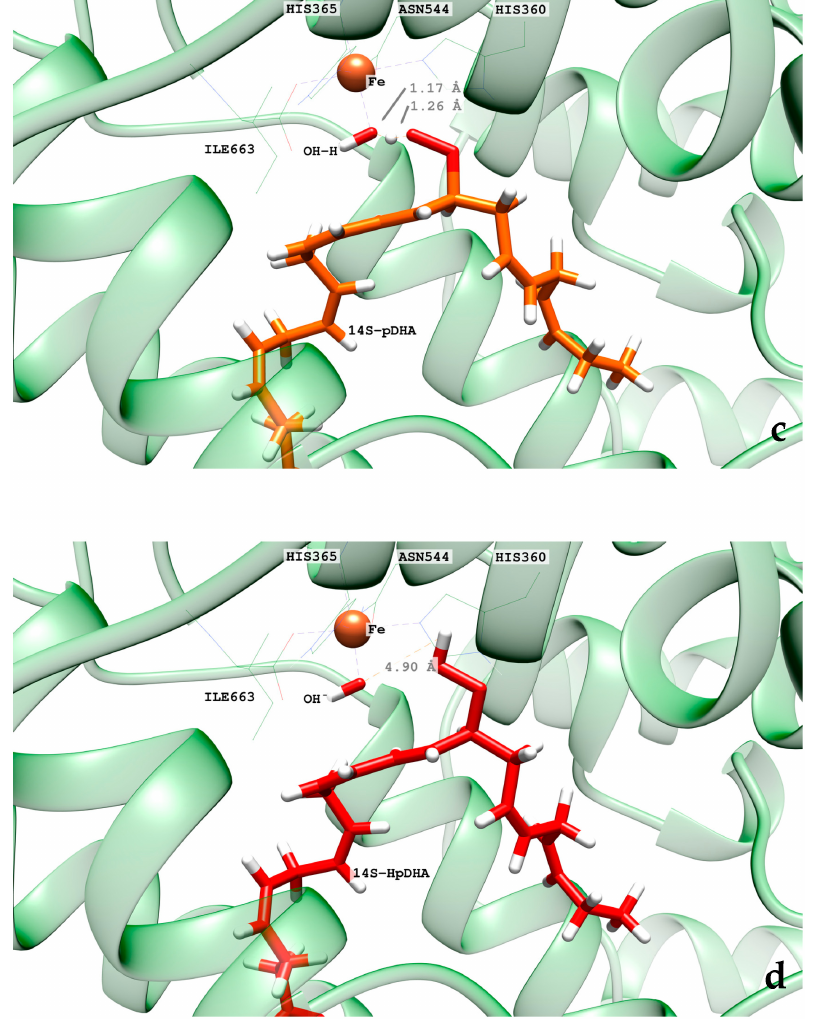
Figure 15. Images of the transition state structure (TS1) ( a ), intermediate (INT1) ( b ), transition state structure (TS2) ( c ), and the final 14S-H(p)DHA product ( d ) (frame 8721) in hALOX12. The distances between the outer oxygen of the peroxo group and the water hydrogen atom are given for TS1 and INT1. The distances corresponding to the shifting hydrogen atom are indicated for TS2 and the final 14S-H(p)DHA product.